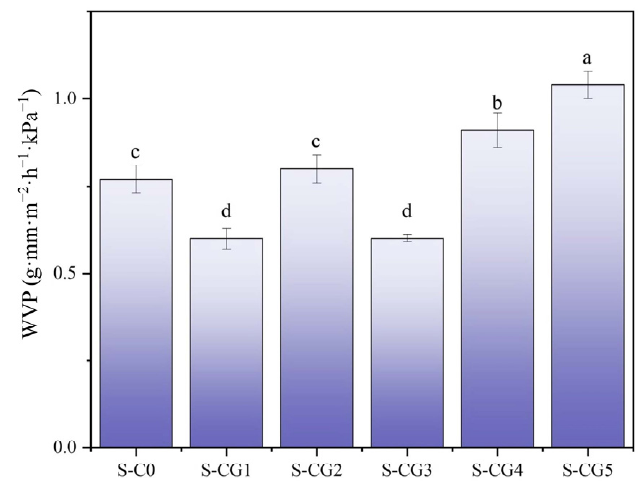
Figure 7. The water vapor permeability of composite films. Results are expressed as average, and different letters (a–d) indicate significant differences ( p < 0.05).